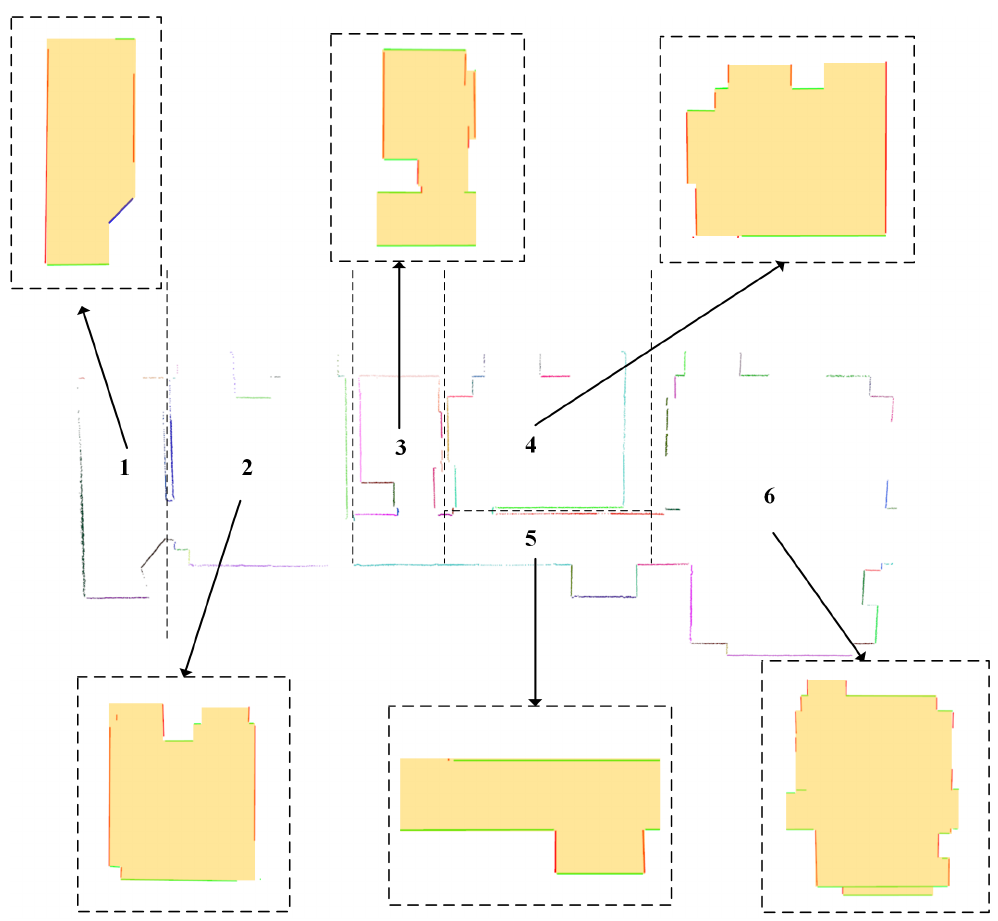
Figure 17. The results of sub-contours extraction: The extracted contours are rendered in the yellow background (from layer 48). 1–6 indicate the sub-floorplans in the 2D